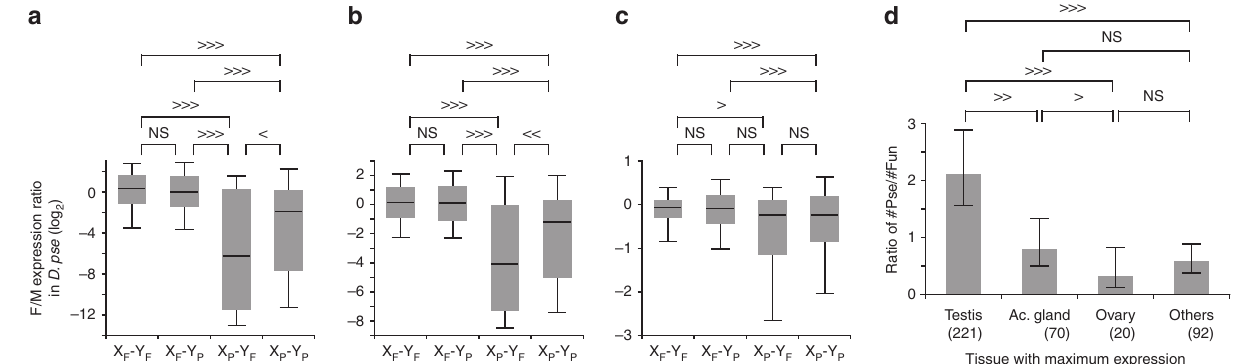
Figure 4 | Relationship between pseudogenization and gene expression. Statistical significance was calculated based on a Monte Carlo simulation with 1,000 bootstrap replicates: 444 or ooo , P o 0.001; 44 or oo , P o 0.01; 4 or o , P o 0.05; NS, P Z 0.05. ( a – c ) Ratios of female to male gene expression in several tissues of D. pseudoobscura . The 1,672 D. pseudoobscura expressed genes whose orthologues are present in D. obscura and have not experienced any inter-chromosomal translocation after splitting from D. obscura were analysed. Tissues analysed are as follows: ( a ) Ovaries in females and testes in males, ( b ) abdomens, and ( c ) abdomens after removing gonads. The lines in the boxes represent medians, 50% of values are included in the boxes, and 80% of values are included within the bars. X F -Y F , a group of genes whose orthologues are functional on both neo-X and neo-Y; X F -Y P , a group of genes whose orthologues are functional on the neo-X and non-functional on the neo-Y; X P -Y F , a group of genes whose orthologues are non-functional on the neo-X and functional on the neo-Y; X P -Y P , a group of genes whose orthologues are non-functional on both neo-X and neo-Y. The Mann-Whitney U test also showed Supplementary Methods for details). Error bars indicate the 95% confidence interval based on a Monte Carlo simulation with 1,000 bootstrap replicates. Numbers in parentheses are the numbers of genes with maximum expression in the respective tissues. In this analysis, only genes for which a cFPKM in a tissue was at least twofold compared with that in any of other tissues examined were considered to remove the genes for which cFPKMs were similar in multiple tissues. See Supplementary Fig. 5 for other tissues and Supplementary Fig. 7 for the results under different conditions.